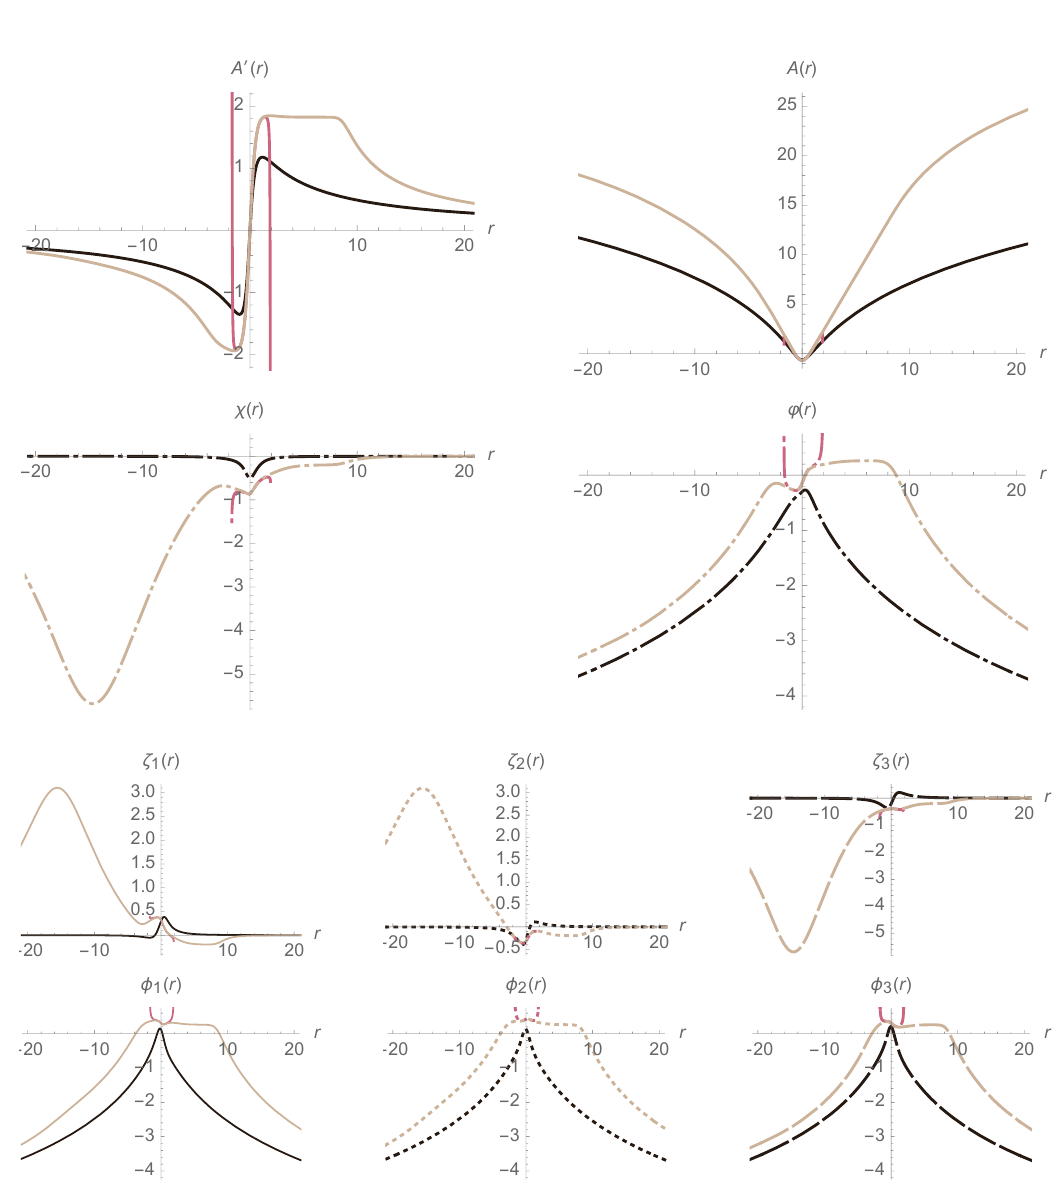
Figure 25. SO(4) / U(3) (brown), SYM/SYM (black) and singular (red) Janus solutions with N = 1 supersymmetry and SO(3)